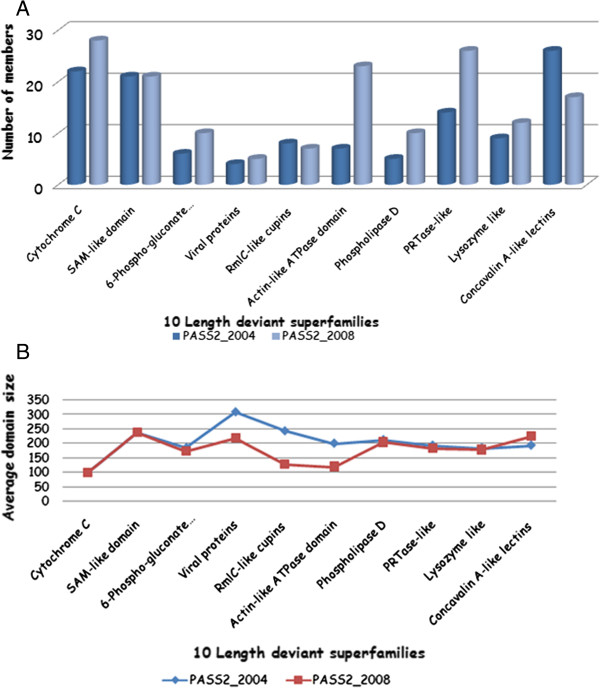
Length deviant groups tend to accumulate longer members. These parameters will enable differentiation between the database versions in terms of domain length. A) Distribution of number of members in two PASS2 versions for ten length-deviant superfamilies, B) Change in average domains size for the ten length-deviant superfamilies.